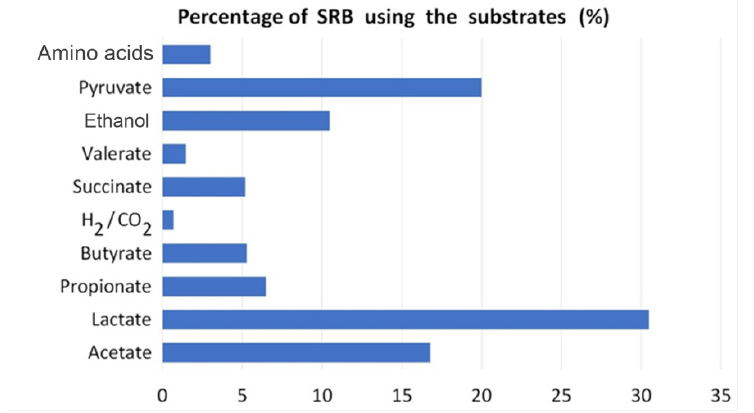
Figure 3. Different types of electron donors used by intestinal SRB which were isolated from human fecal samples (data from Gibson et al., 1988 [36]).